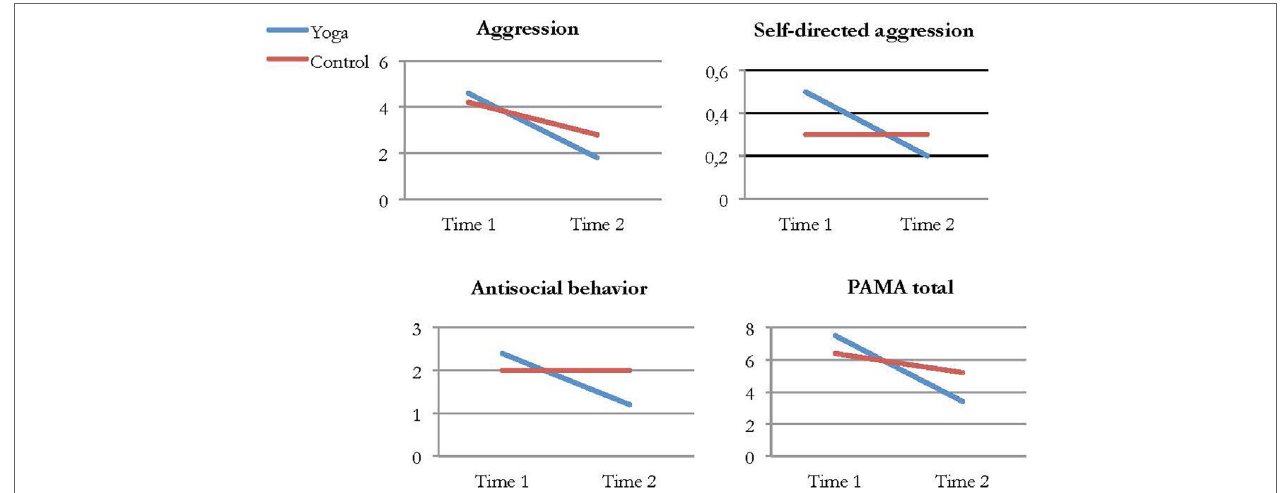
FigUre 2 | Average ratings of aggression, self-directed aggression, antisocial behavior, and total score on the Prison Adjusted Measure of Aggression (PAMA) in the yoga and control group at Time 1 and Time